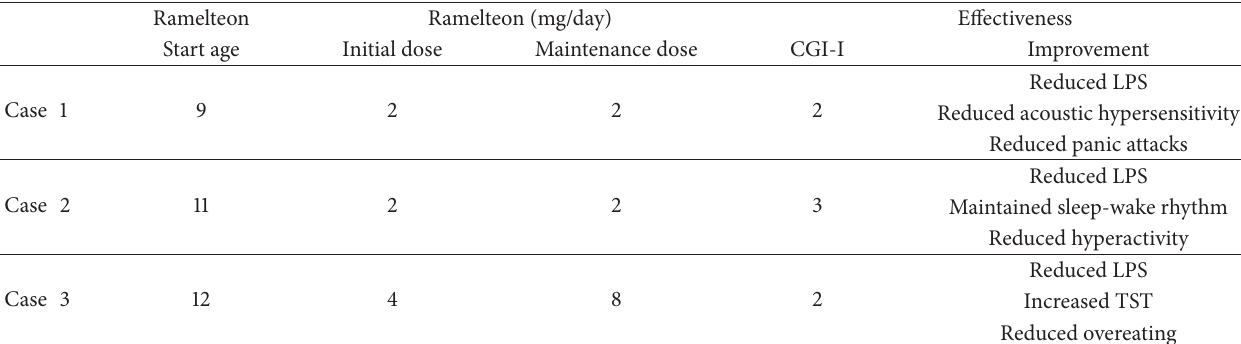
Table 2: Effectiveness of